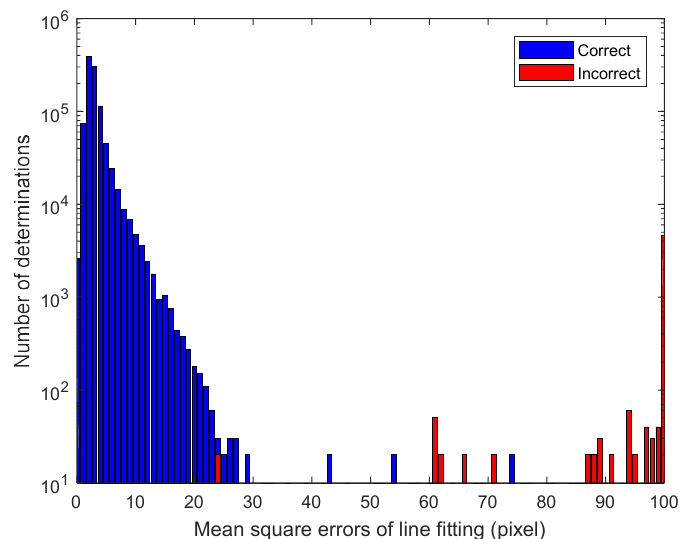
Figure 14. Separation of correct and incorrect fast determinations under different mean square errors of line fitting MR .